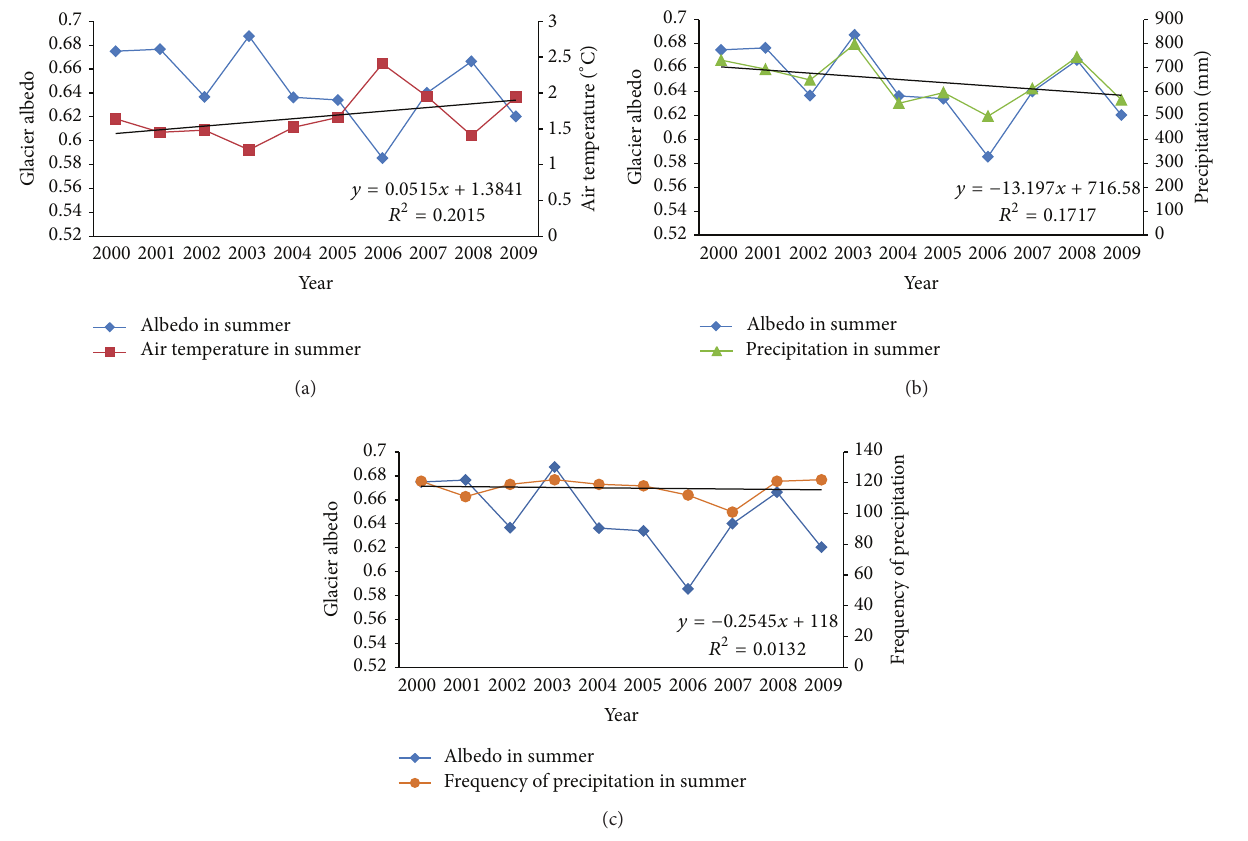
Figure 7: Annual variations of glacier albedo and meteorological factors in summer during 2000–2009. (a) Air temperature. (b) Precipitation levels. (c) Frequency of